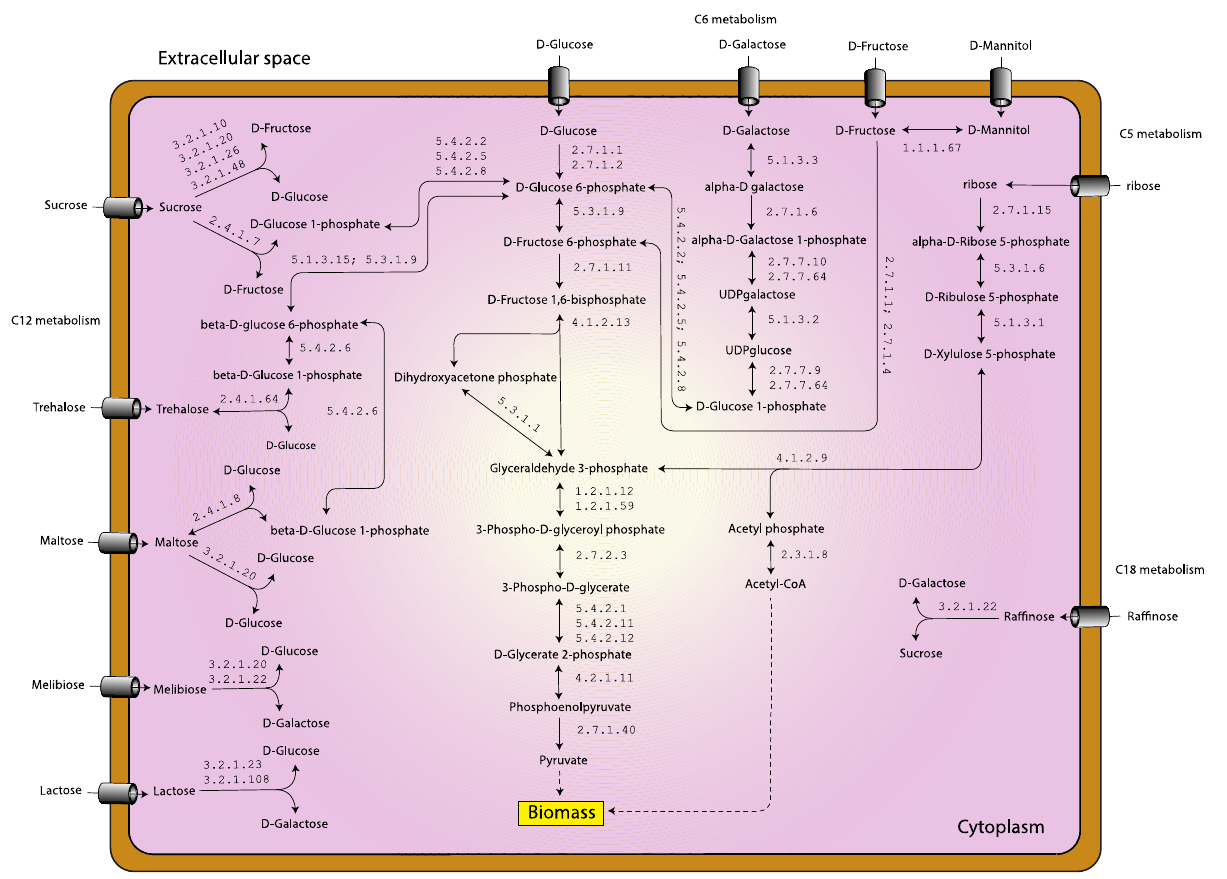
Figure 2. A highlight metabolic landscape of L. reuteri KUB-AC5 for growth and biomass